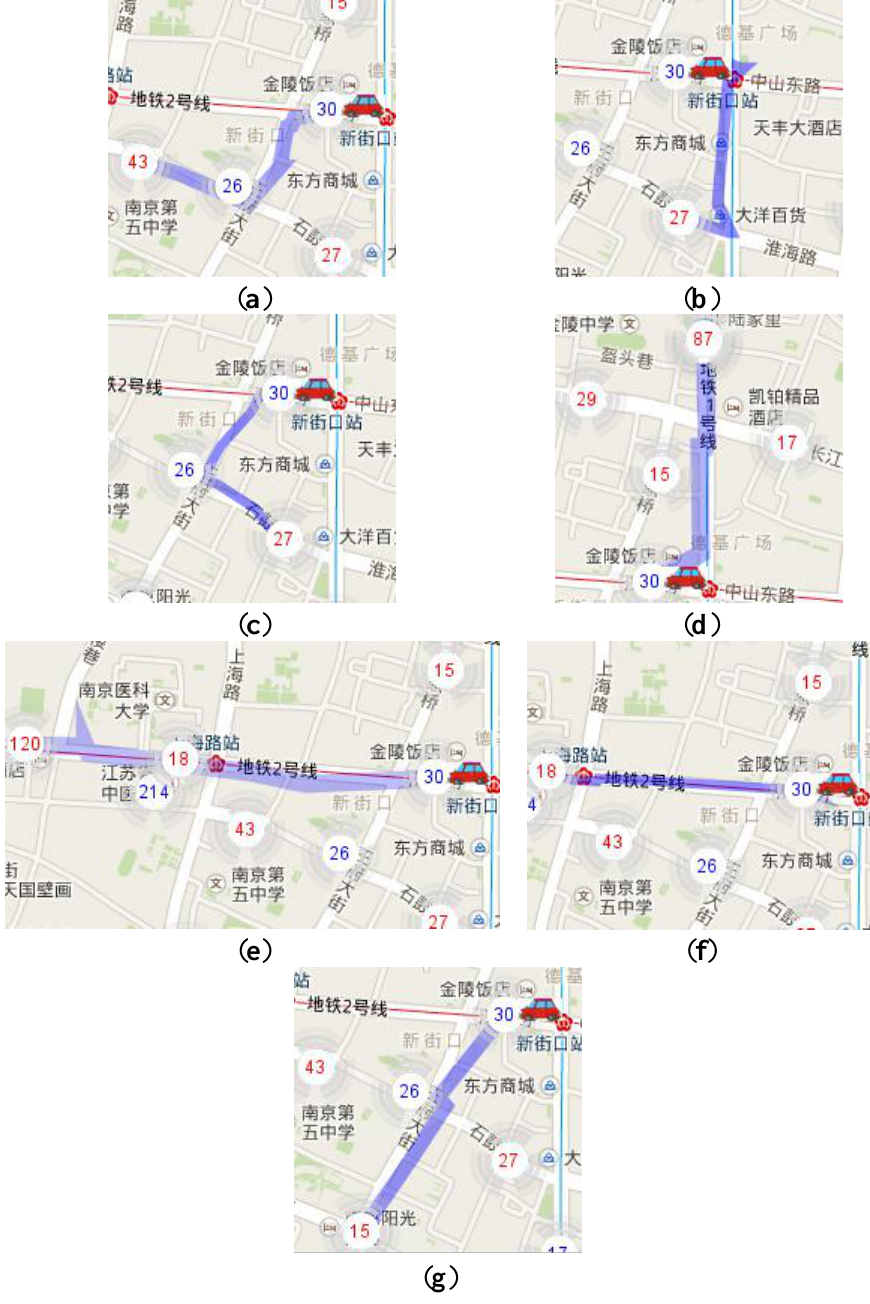
Figure 11. ( a ) “30”–“43”; ( b ) “30”–“27”-1; ( c ) “30”–“27”-2; ( d ) “30”–“87”; ( e ) “30”–“120”; ( f ) “30”–“18”; ( g )